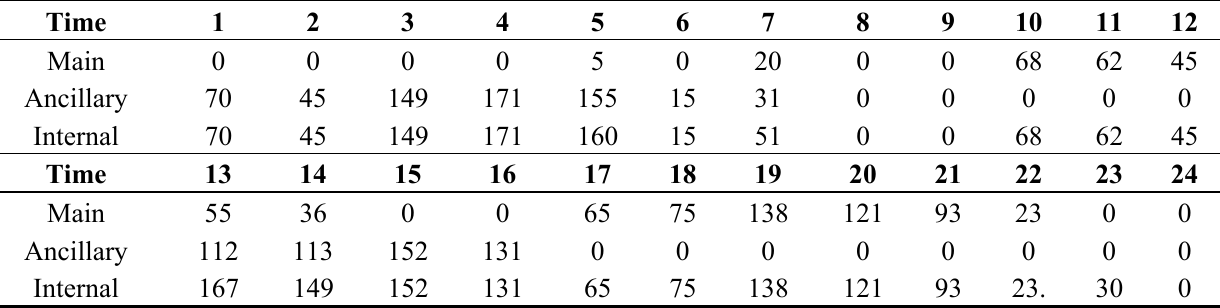
Figure 10. Production amounts of CHP generators adjusted by ancillary internal trading. Table 3. Amounts of internal trading in Step